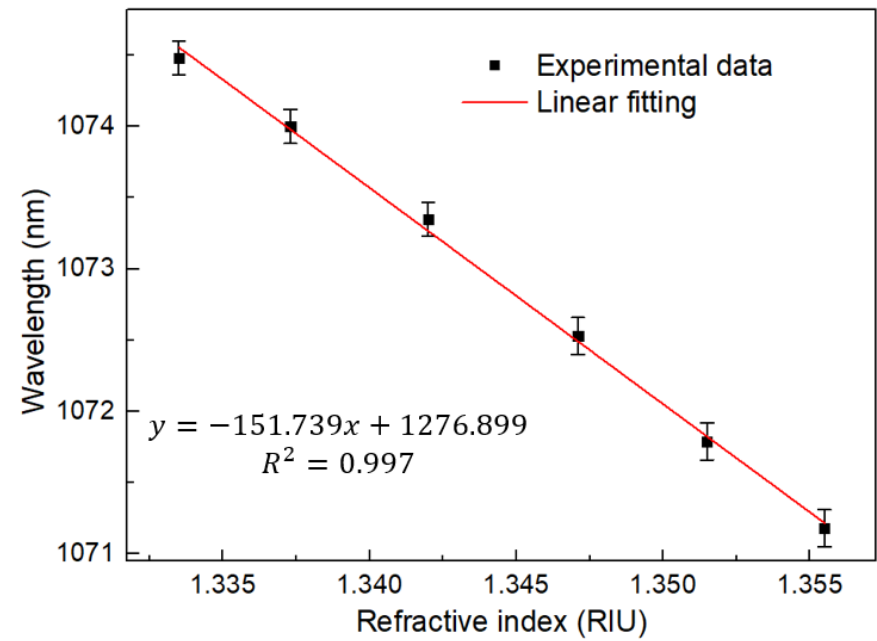
Figure 14. Linear regression curve of RI with wavelength at FRL.